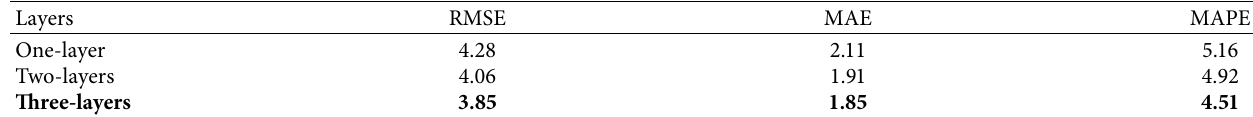
Figure 8: Estimated speed by the data-driven method in the Los Angeles case. (a) one-layer. (b) two-layer. (c) three-layer. Table 4: Compare evaluation indicators in the machine learning model.